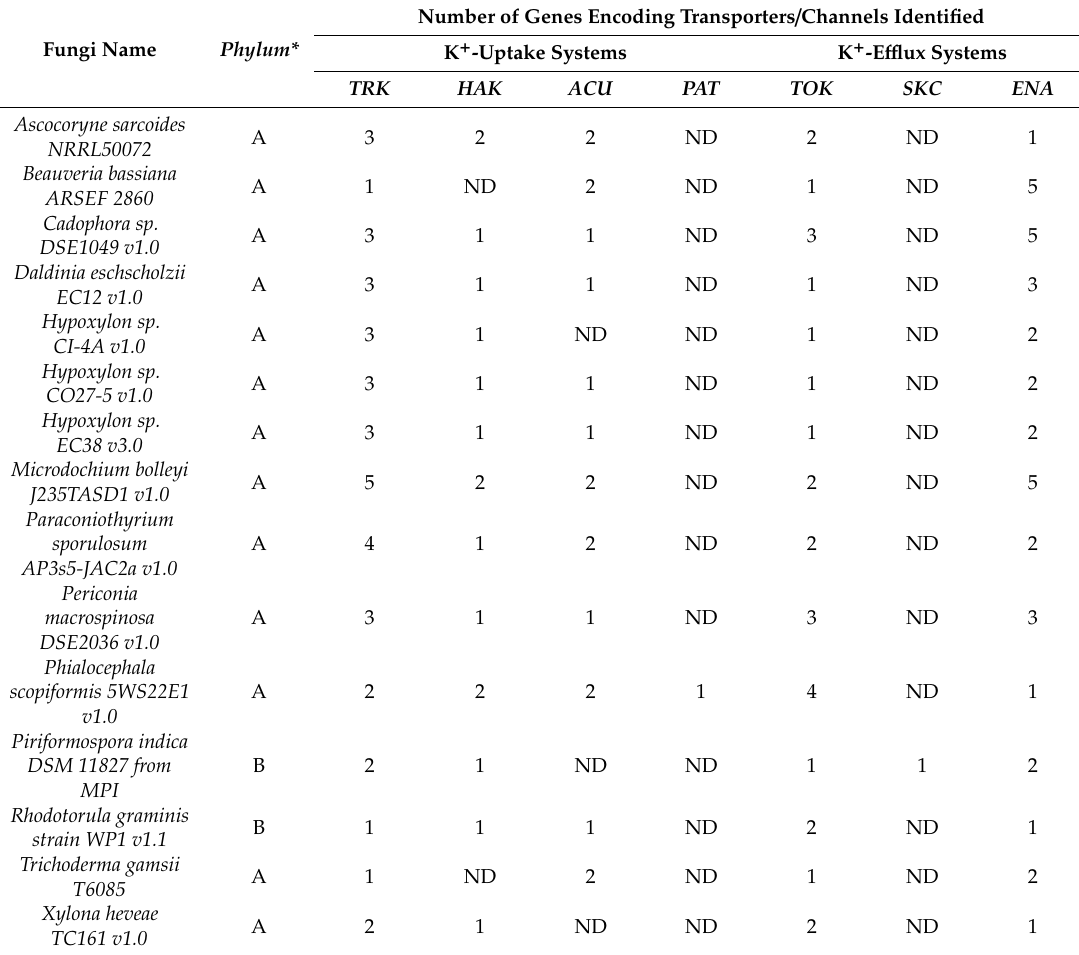
Table 2. Families of putative K + transporters identified in the genome of the endophytic fungi in JGI. (https: // genome.jgi.doe.gov / endophytic_fungi /